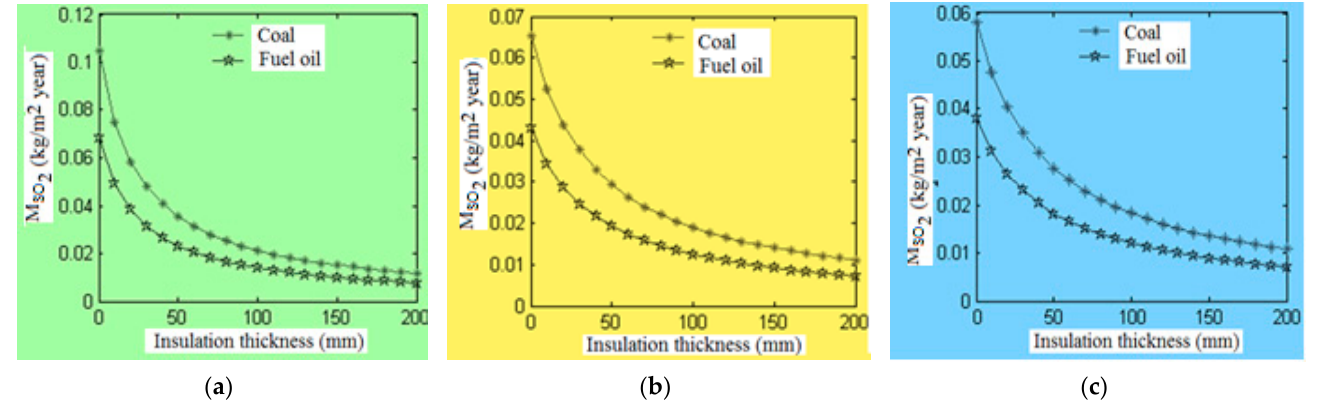
Figure 8. Correlation of SO 2 emission with insulating thickness for diverse energy source types: ( a ) Porous light brick wall; ( b ) Gas concrete wall; ( c ) Bims wall.